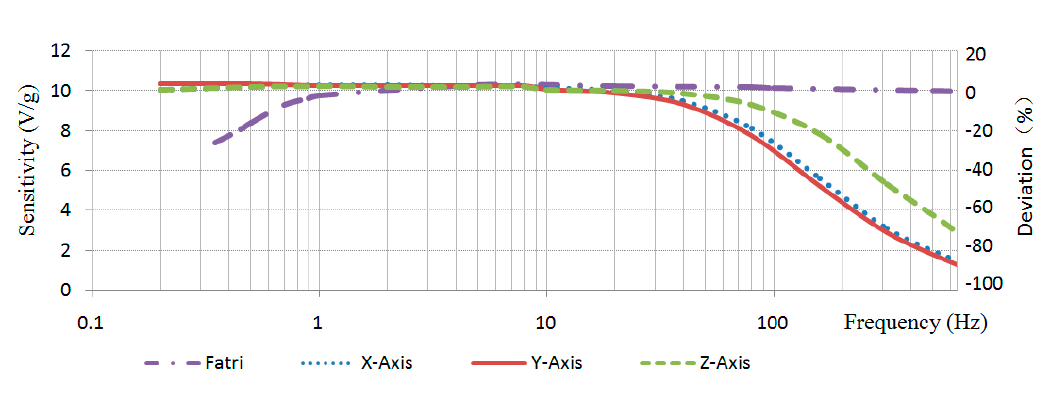
Figure 8. The variations of sensitivities with the frequency of inputs.